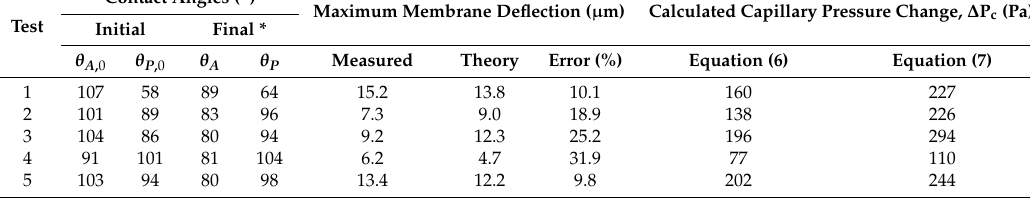
Table 2. Results from single-active-surface tests—contact angles on active and passive surfaces as measured by side view camera; measured membrane deflection and theoretical value calculated from measured angles; values of change in capillary pressure as determined from measured angles (Equation (6)) and with a no hysteresis model (Equation (7)).